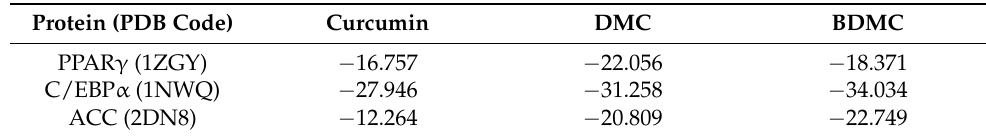
Table 2. The negative CDOCKER energy of curcumin and its derivatives with PPAR γ , C/EBP α , and